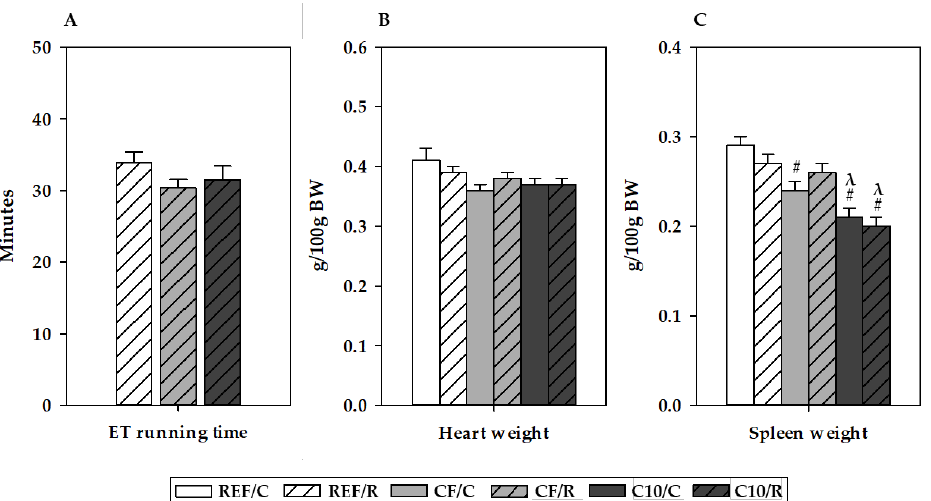
Figure 1. Running time during the final exhaustion test for running (R) rats ( A ) and relative heart ( B ) and spleen ( C ) weights for all groups. REF, reference diet; CF, 5% cocoa fiber-enriched diet; C10, 10% cocoa-enriched diet. The control (C) groups are represented by smooth bars, and the R groups are represented by striped bars. Data are expressed as mean ± standard error of the mean (SEM) (n = 8). Statistical differences (a Kruskal – Wallis test followed by a Mann – Whitney U test): # p < 0.05 vs. the same exercise condition in the REF diet; λ p < 0.05 vs. the same exercise condition in the CF diet. 3.2. Organ Weight and Plasma Cortisol and NA Concentrations Sixteen hours after performing the final ET, tissue and blood samples were obtained. Acute exercise did not modify the weight of the heart or spleen (Figure 1b,c). Likewise, the heart weight was not influenced by the C10 or CF diets. However, the intake of the C10 diet lowered the relative spleen weight in C10/C and C10/R animals ( p = 0.001), whereas the CF diet decreased it in sedentary CF/C rats ( p = 0.007). On the other hand, 16 h after the final ET, REF/R rats showed a lower concentration of plasma cortisol than REF/C animals (about a 40% decrease, p = 0.035; Figure 2a). The C10 diet decreased the plasma cortisol concentration in C10/C animals, with this change only being significant when it was compared with in the CF/C group ( p = 0.016). Neither the acute exercise nor the experimental diets induced statistically significant changes in plasma NA (Figure 2b). Figure 2. Plasma cortisol ( A ) and noradrenaline ( B ) concentrations 16 h after performing the final exhaustion test. REF, reference diet; CF, 5% cocoa fiber-enriched diet; C10, 10% cocoa-enriched diet.